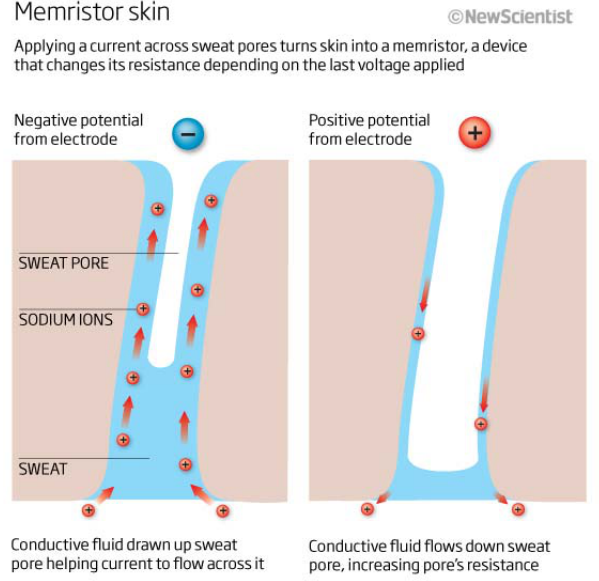
Fig. 7: Cross-sectional view of a sweat pore in the skin. From New Scientist with permission [16], (© 2011 Reed Business Information Ltd, England. All rights reserved. Distributed by Tribune Media Services). Fig. 8: Equivalent electrical circuit model of the skin, now also